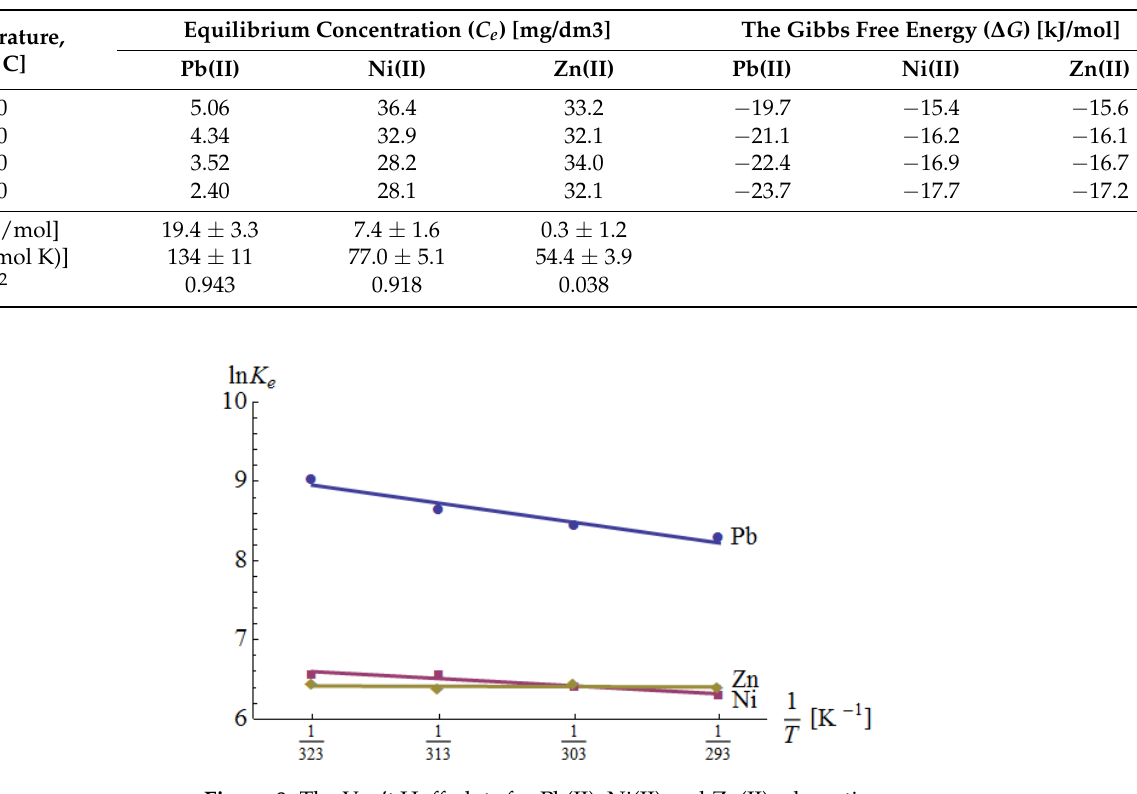
Table 8. The thermodynamic studies’ results for the Pb(II), Ni(II), and Zn(II) adsorption (the initial concentration was 100 mg/dm 3 ).